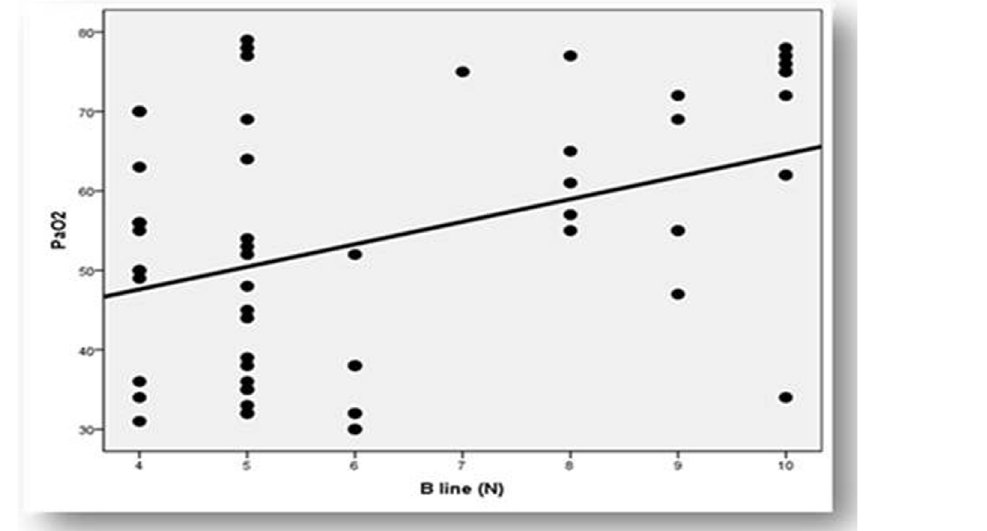
The relation between B-line number and PaO 2 .